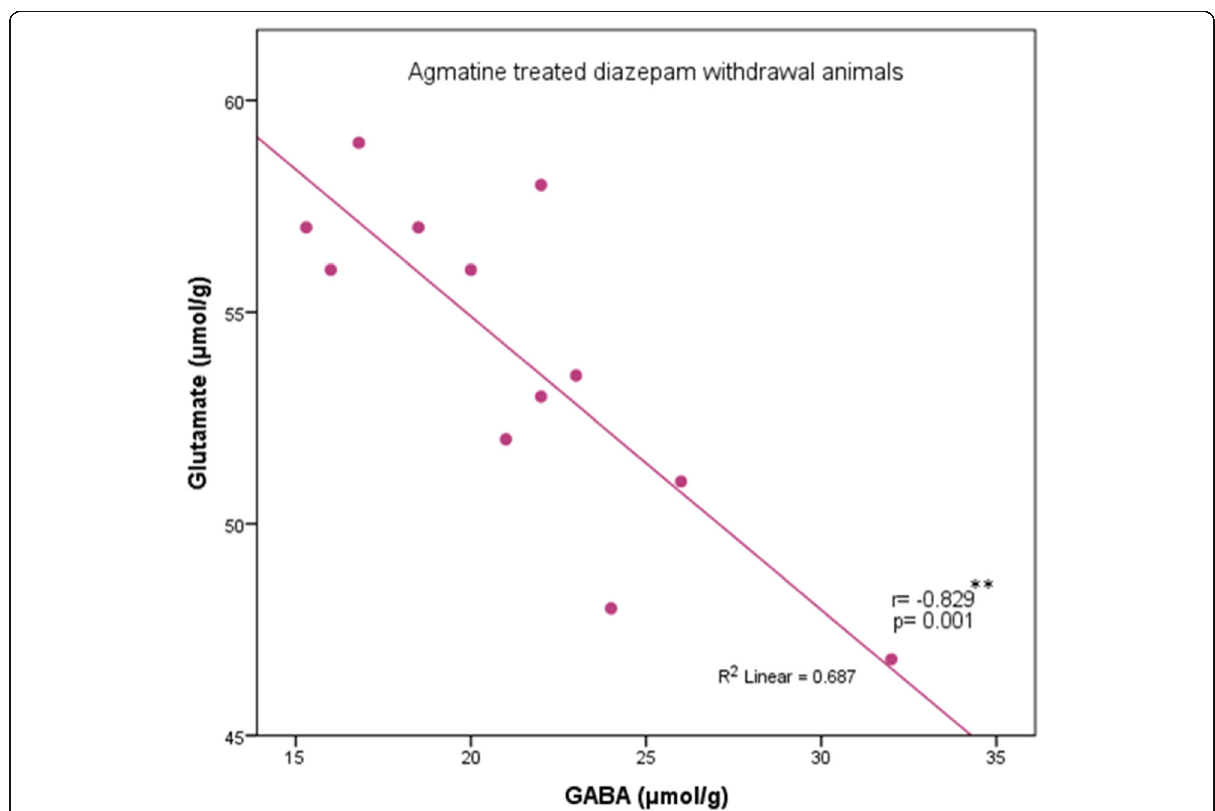
Fig. 8 Correlation between GABA and glutamate concentration in agmatine-treated diazepam withdrawal animals. Correlation is significant at * p < 0.05, ** p < 0.01